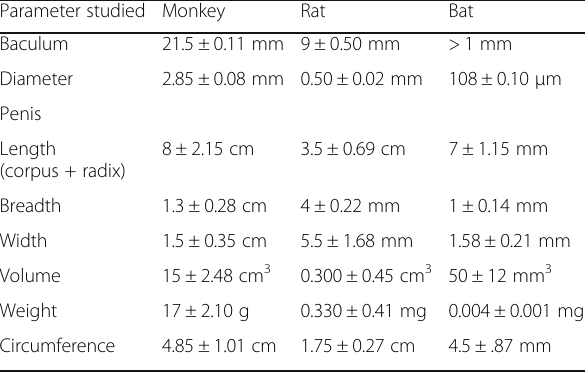
Table 1 Various morphological measurements of the baculum and penis Parameter studied Monkey Rat Bat